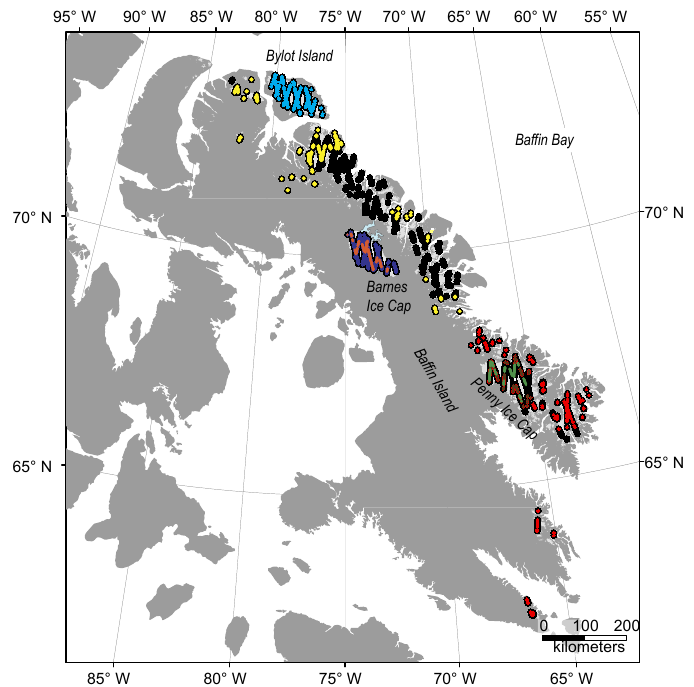
Fig. A4. Locations of ICESat elevations used in study. Underlying black dots ( • ) show all ICESat points used for ICESat-ICESat estimation of 2003–2009 elevation changes. Cyan ( • ), yellow ( • ), blue ( • ), red ( • ), and brown ( • ) dots show the subset of ICESat elevations used for ICESat-CDED differencing for Bylot Island, north Baffin Island, Barnes Ice Cap, south Baffin Island, and the Penny Ice Cap, respectively. Orange ( • ) and green ( • ) dots show the subsample of ICESat elevations that are within a 5km radius of the ATM flight lines and were used to assess the uncertainty in extrapolating ATM-ATM elevation changes to determine regional volume changes.